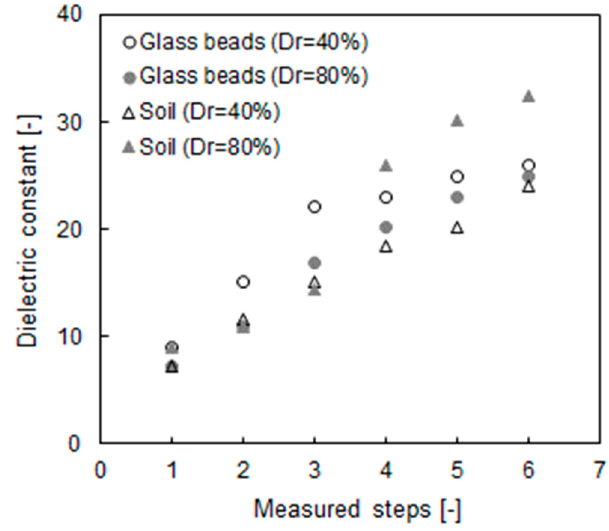
Figure 6. Recorded dielectric constant from TDR with measured steps.